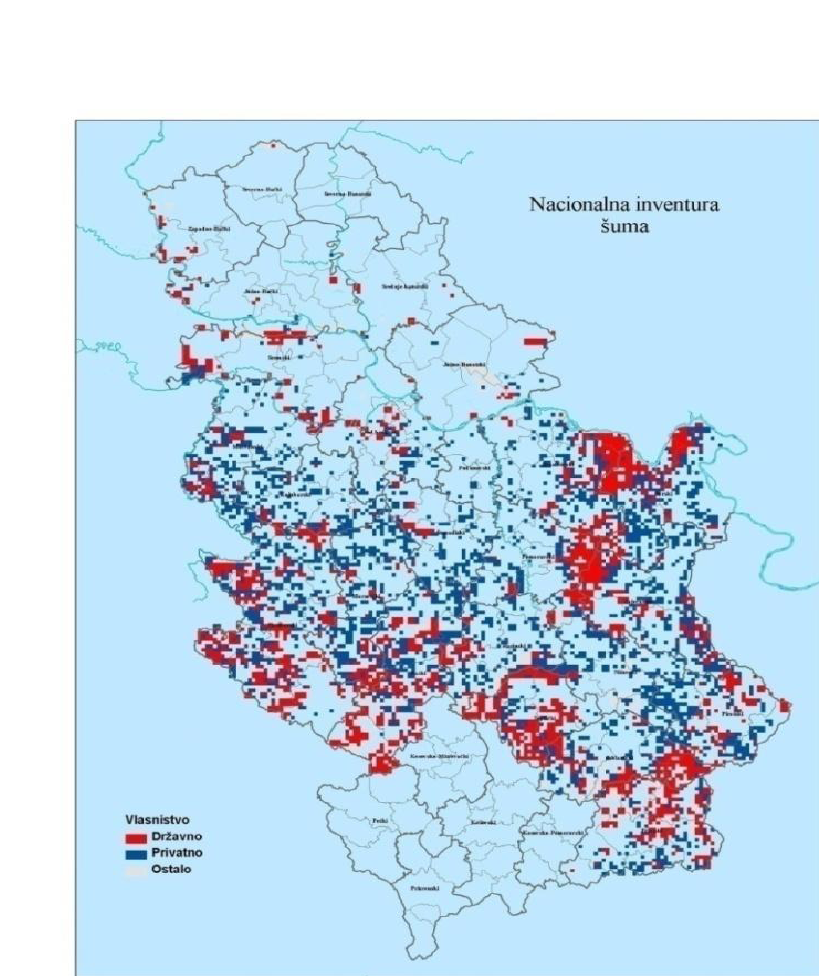
Figure 2 – Forests in the state and private ownership of the Republic of